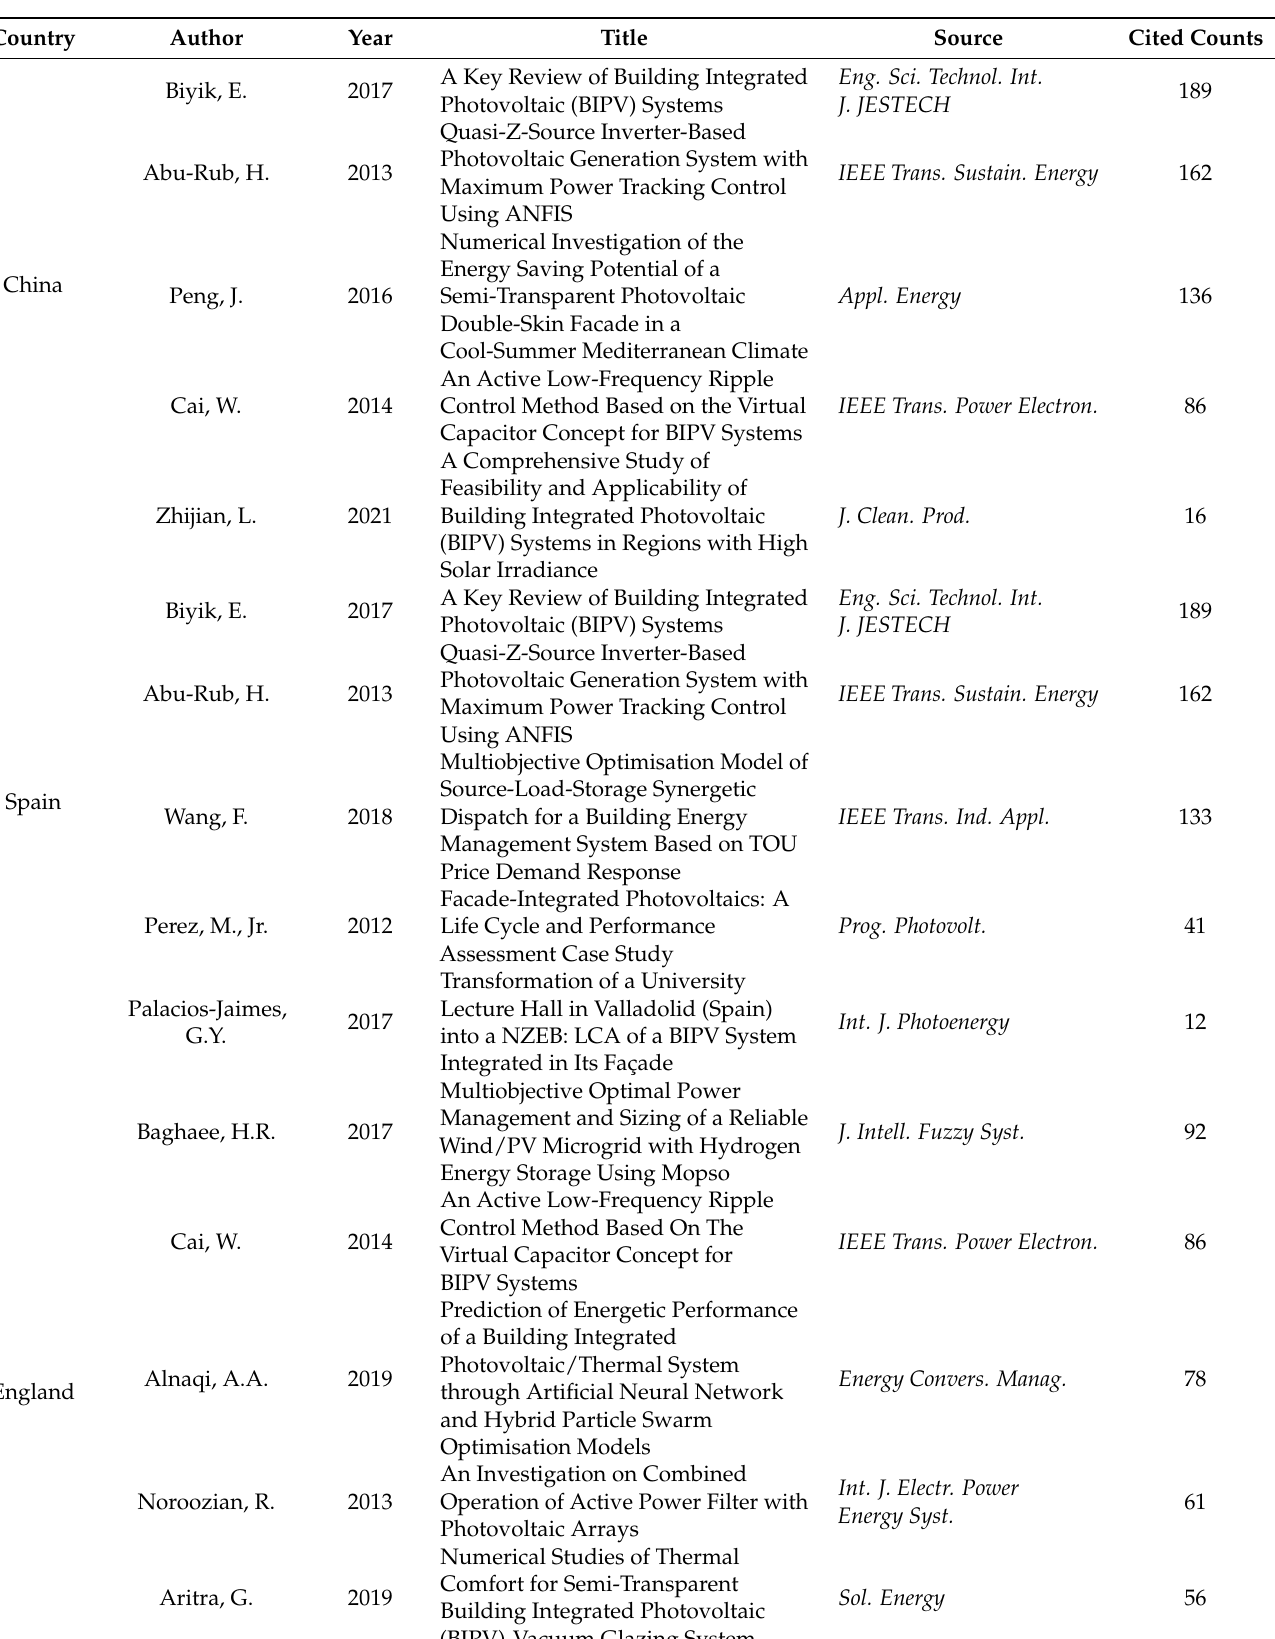
Table 7. The top three countries in the centrality and their top five cited